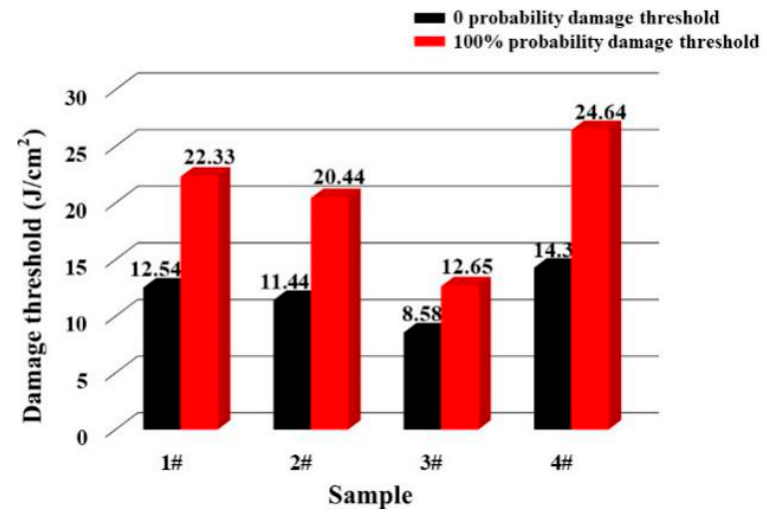
Figure 4. Results of laser damage threshold.